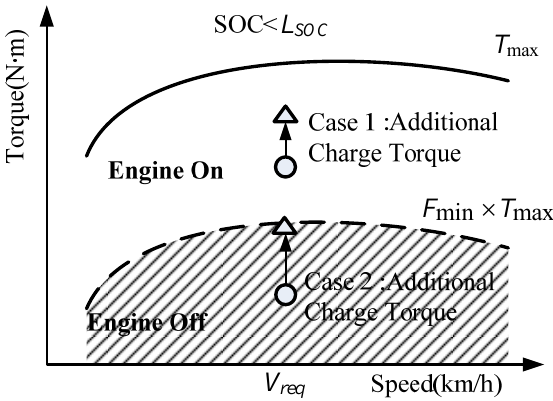
Figure4. Electric assist control